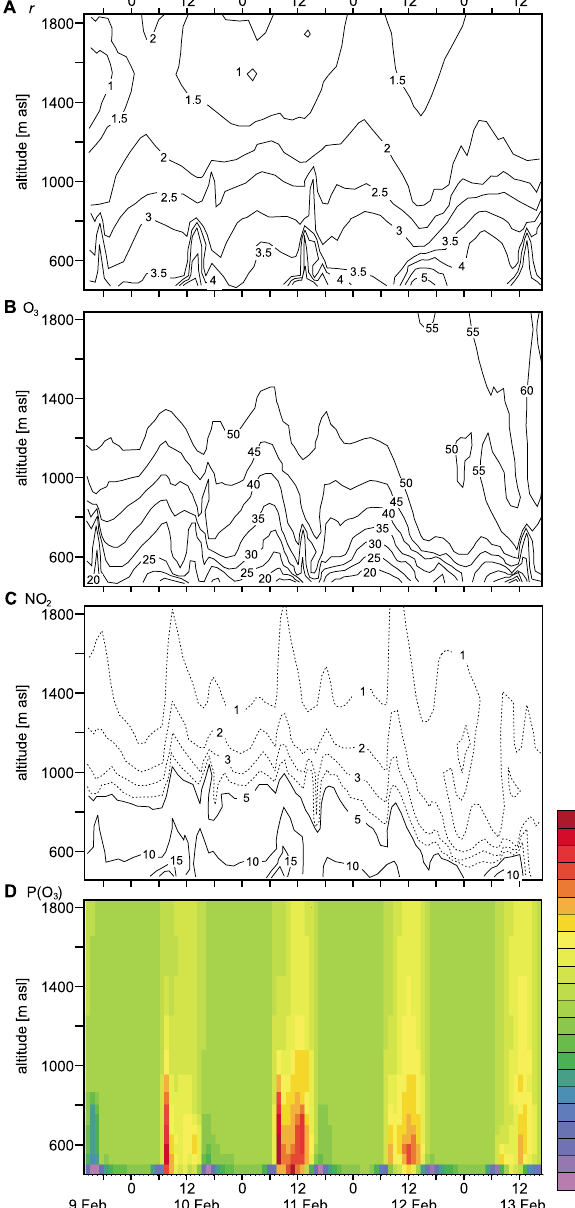
Fig. 8. Modelled time-height cross sections of (a) specific humidity [g/kg], (b) ozone [ppb], (c) NO 2 [ppb], and (d) net chemical ozone production rate [ppb/h] for the location of